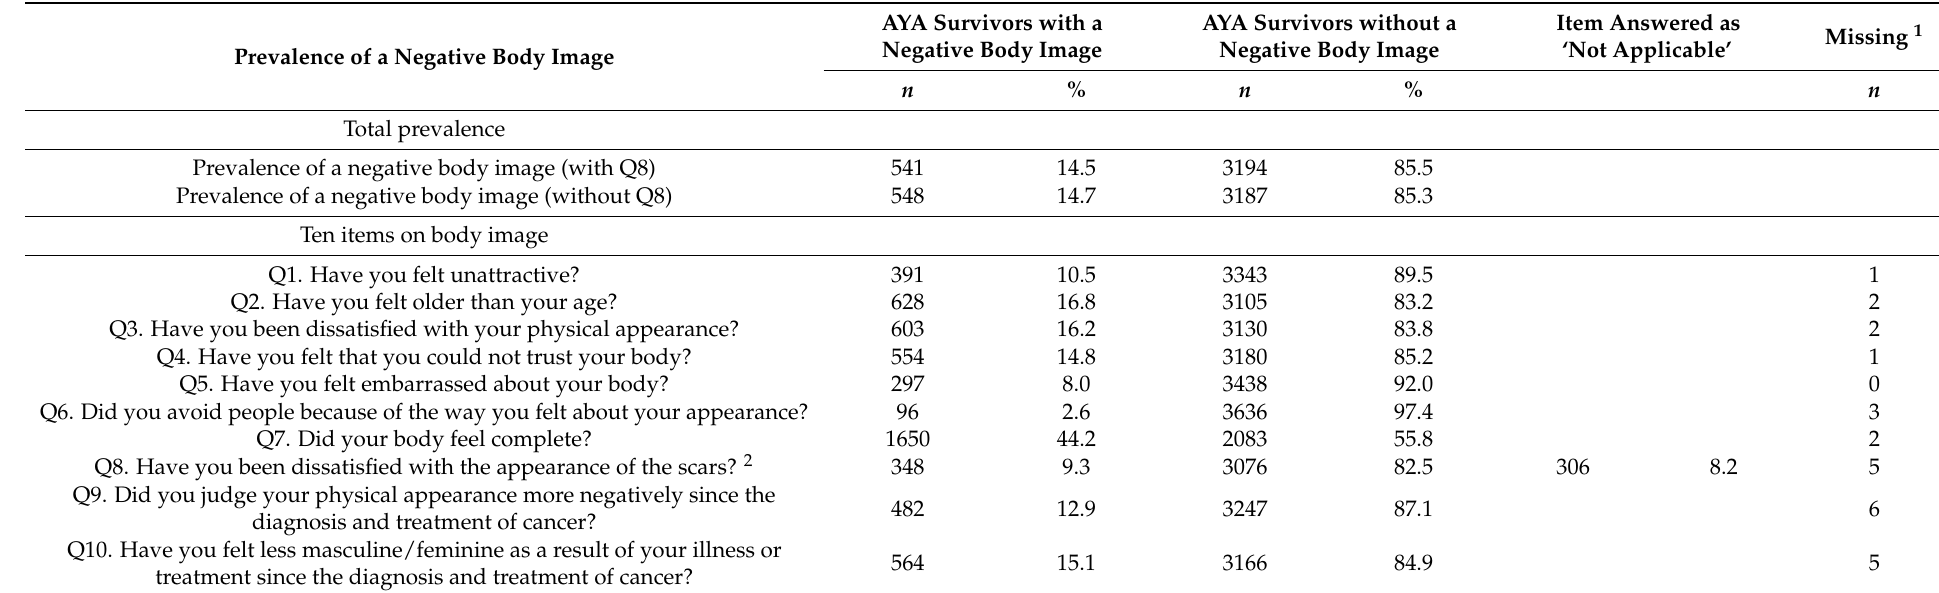
Table 3. Prevalence of a negative body image among AYA survivors.